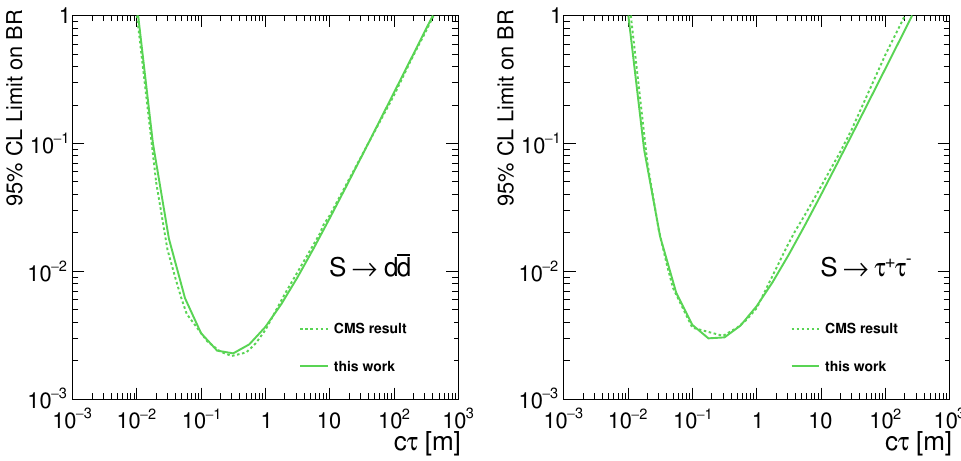
Figure 3 . Comparison of the 95% CL upper limits on the branching fraction Br( h → SS ) as functions of cτ derived with the standalone workflow (solid lines) and the CMS search (dashed lines). In deriving these limits we have considered a 7 GeV LLP decaying into d -quark pairs (left) and τ pairs (right). The limits from this work is shown to agree with CMS search to within 30%